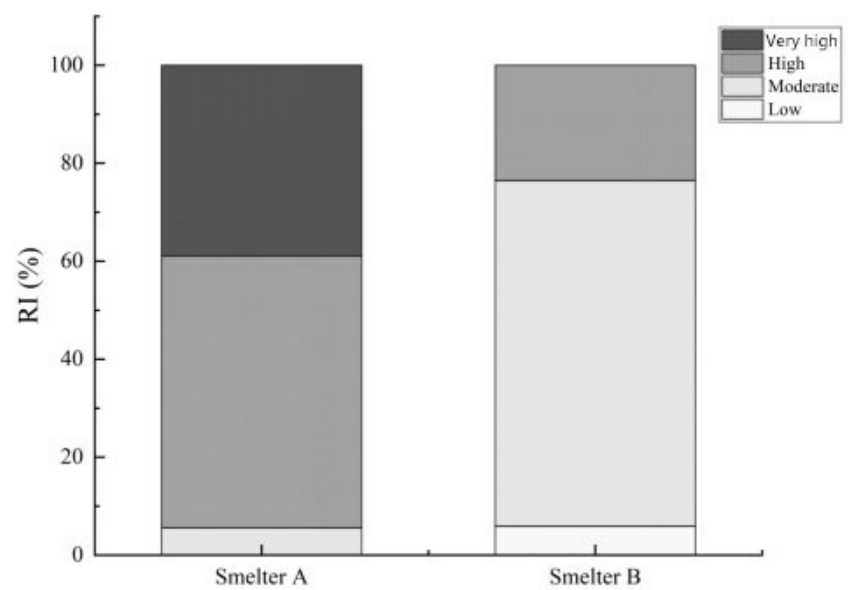
Figure 5. Comprehensive index evaluation results of potential heavy metal ecological risk.